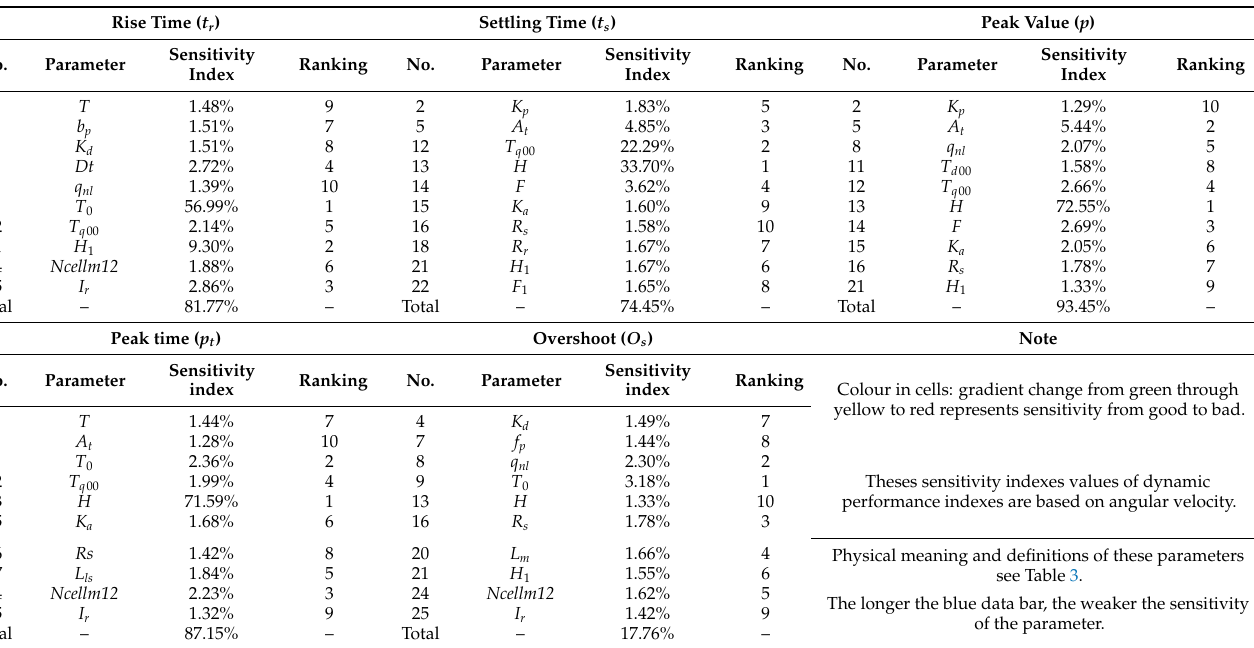
of the parameter.25